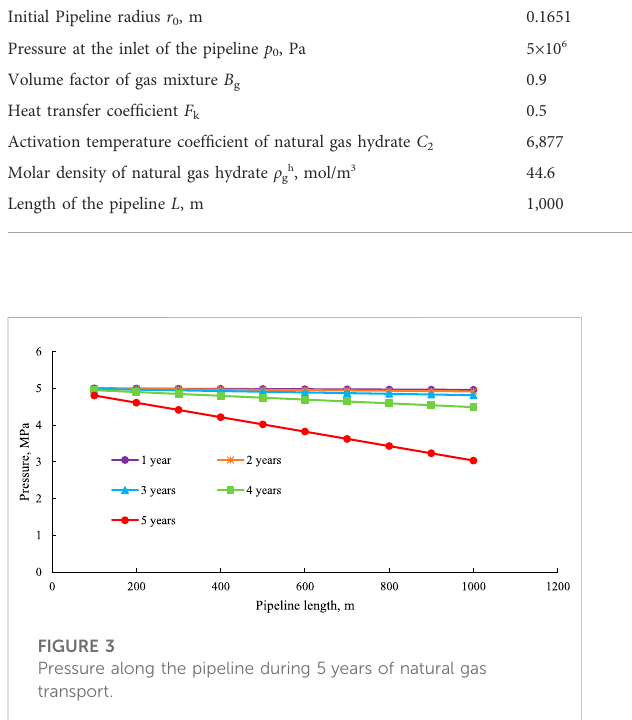
Pressure along the pipelines with changeable radius and constant radius at the fi fth year of natural gas